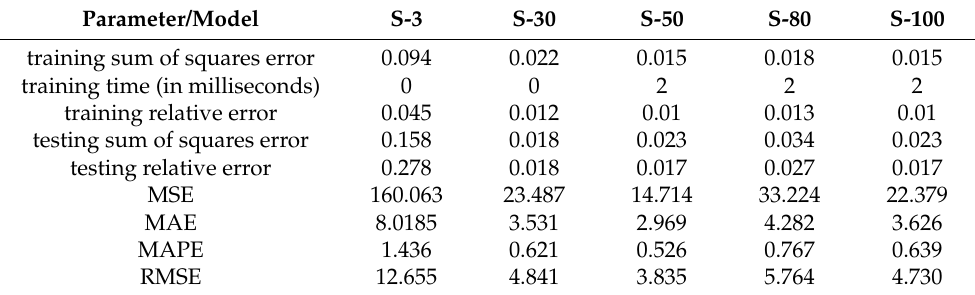
Table 4. Sigmoid-function-based PCA–ELM model for a various number of hidden neurons.